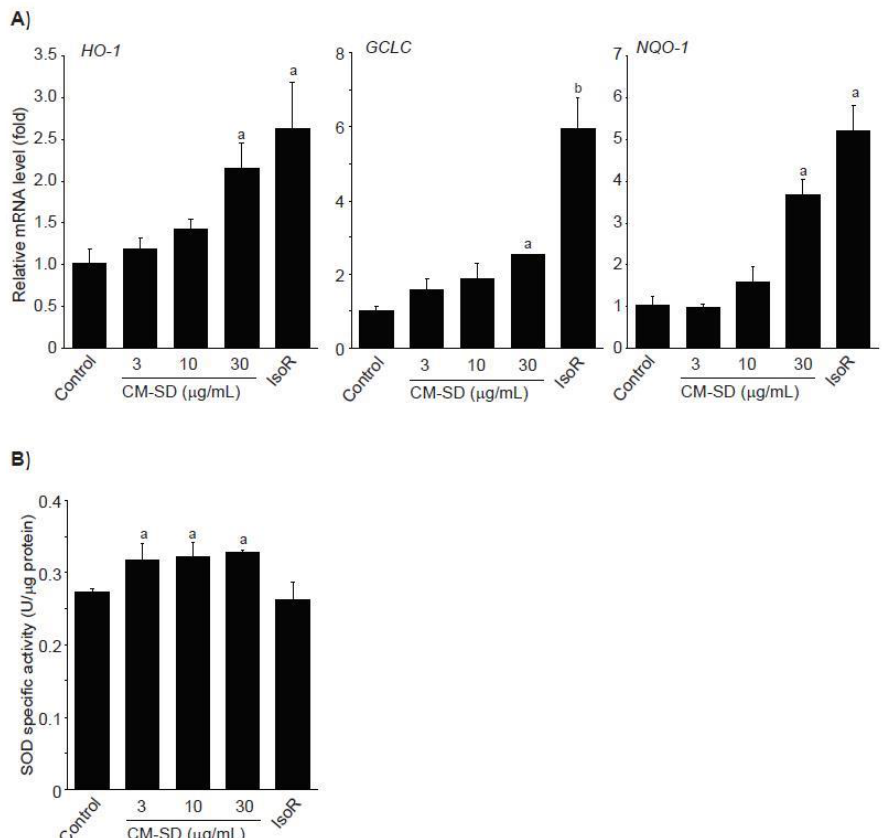
Figure 5. Effect of CM-SD on HO-1, GCLC, and NQO-1 activation ( A ) and SOD activity ( B ). Values are expressed mean ± SD of three separate experiments. Experimental data for HO-1, NQO-1, and SOD were analyzed by LSD test, and the data for GCLC were for Dunnett’s T3 test. a p < 0.01 and b p < 0.05, significant as compared with control.